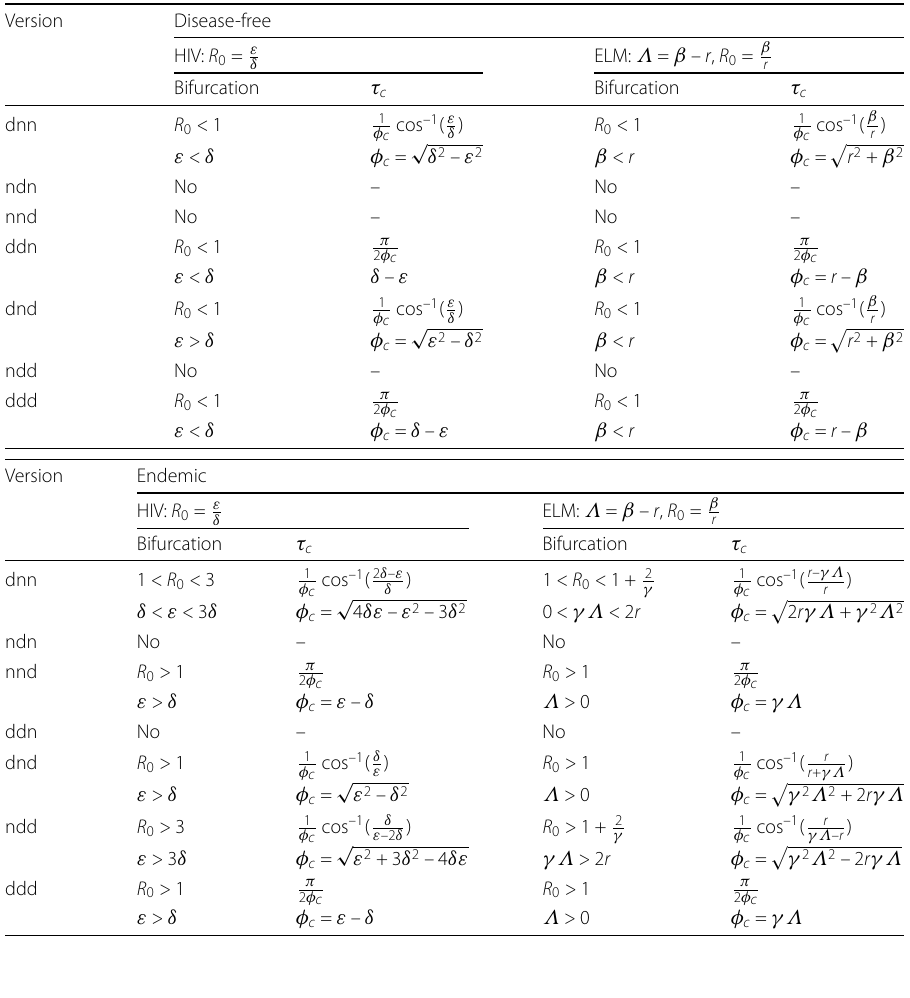
Table 4 Andronov–Hopf bifurcation conditions and values for τ c in HIV and ELM delay models